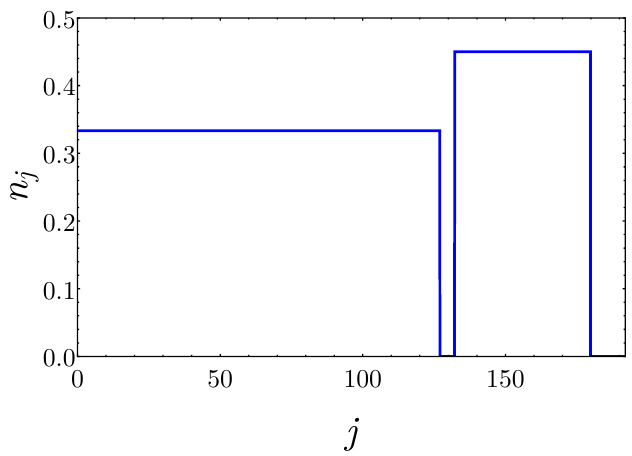
Figure 5 . Occupation numbers n j of single particle states with momentum j for fitting the ν = 1 / 3 Laughlin ground state density ( N = 64